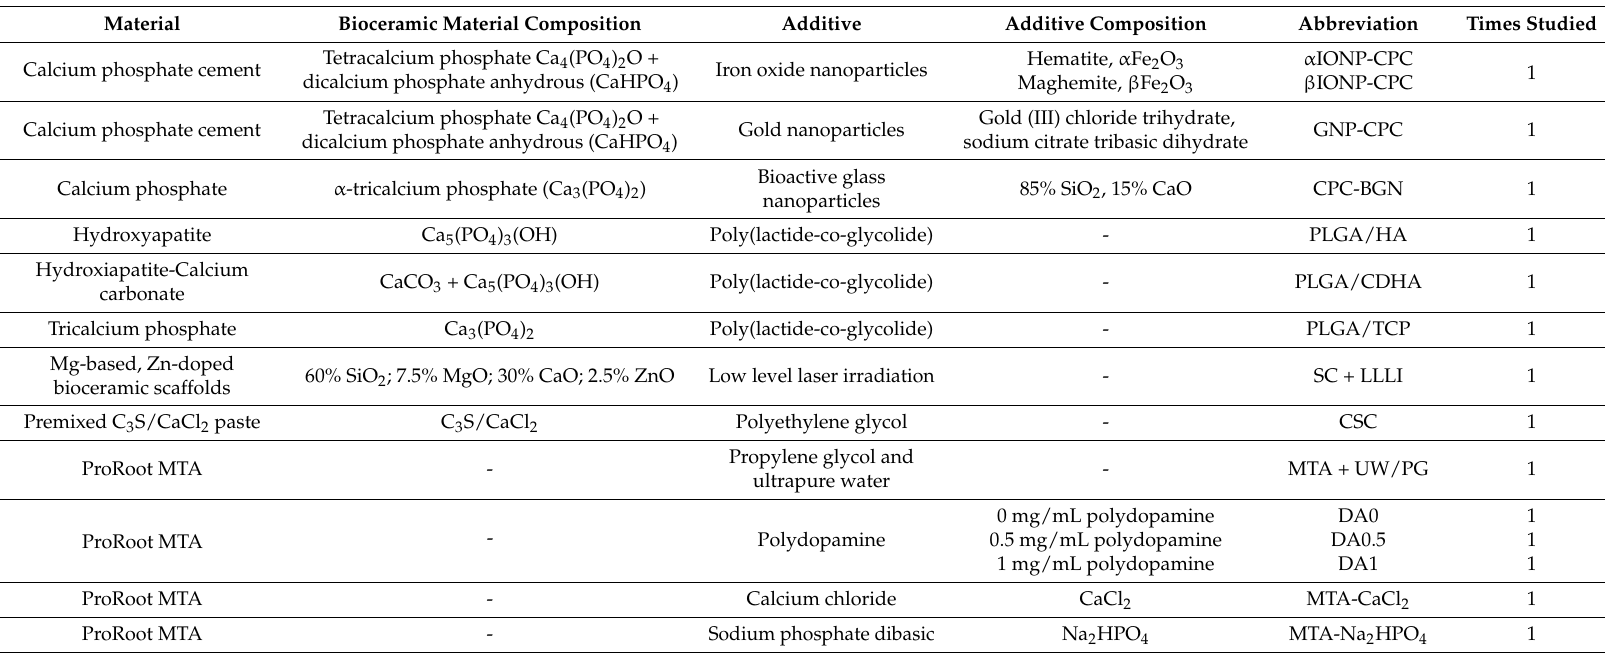
Table 4. List of bioceramic materials and additives